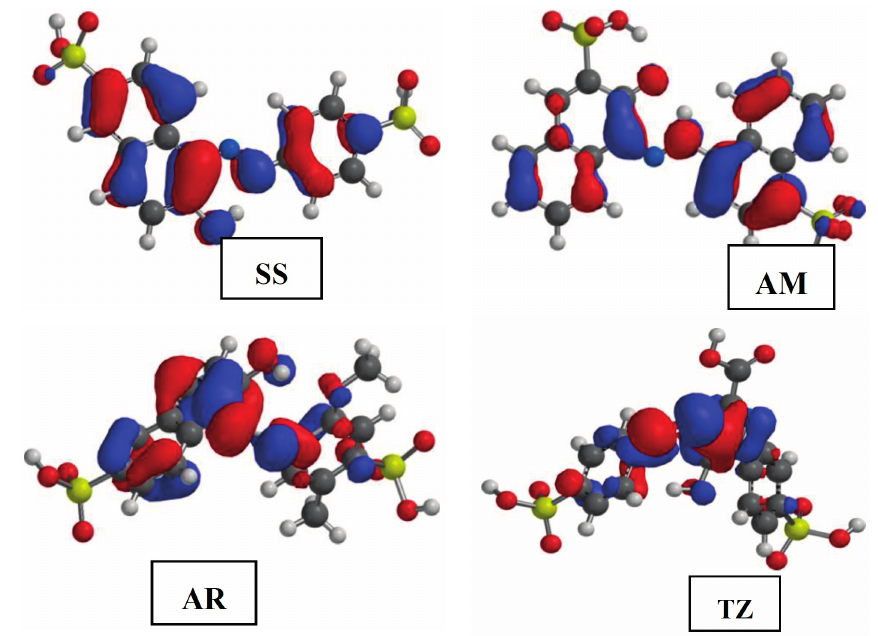
Figure 5. The highest occupied molecular orbitals (HOMO) electron density surfaces for the studied